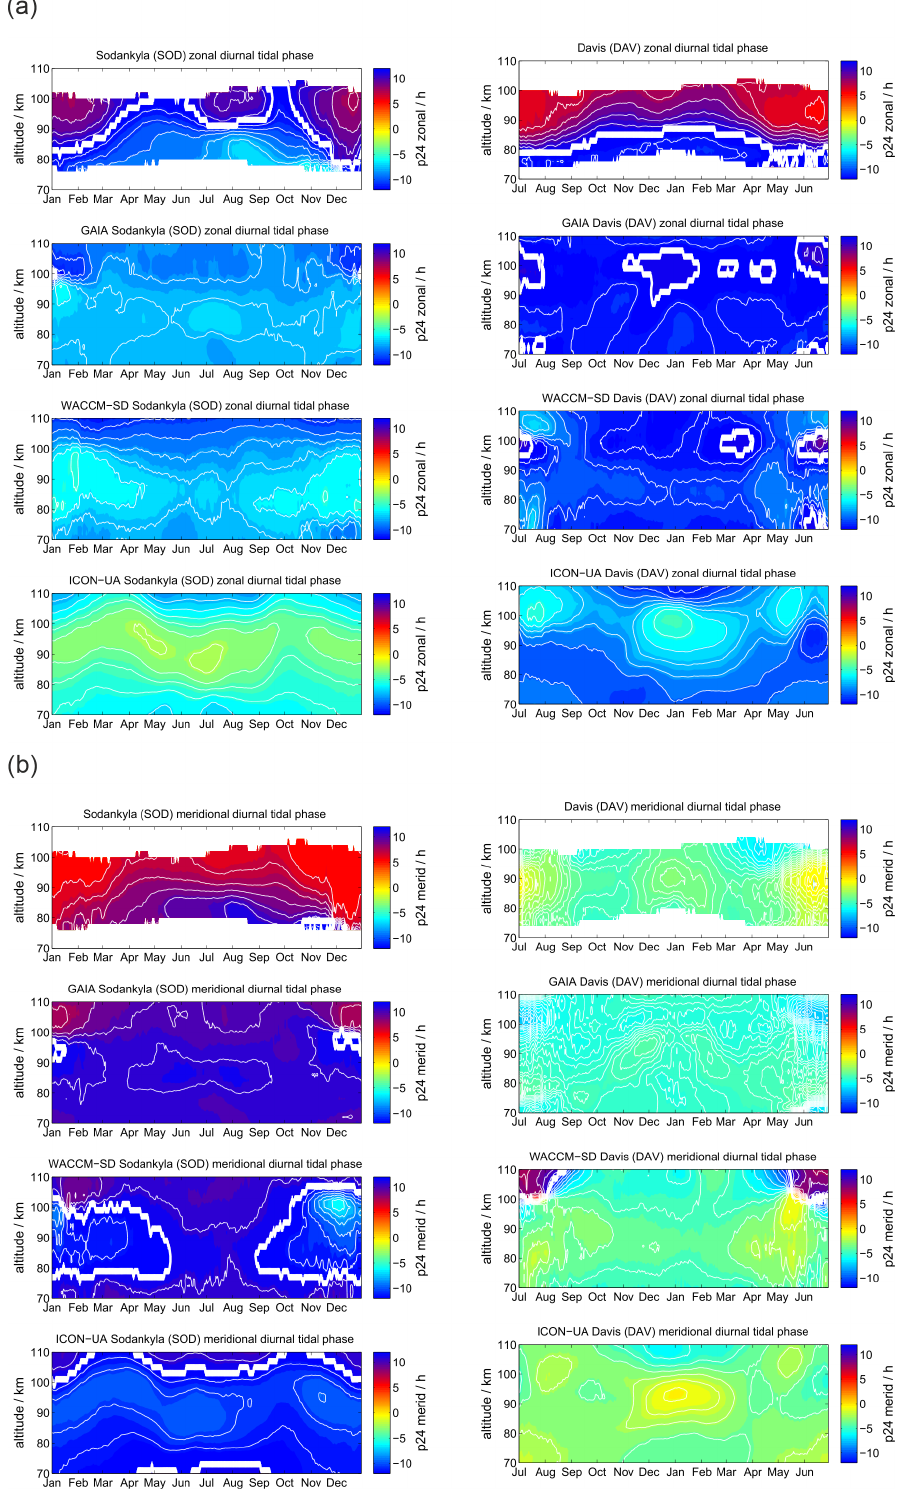
Figure 4. The same as Fig. 3, but for the diurnal tidal phases. The white line indicates a phase jump or the zero phase